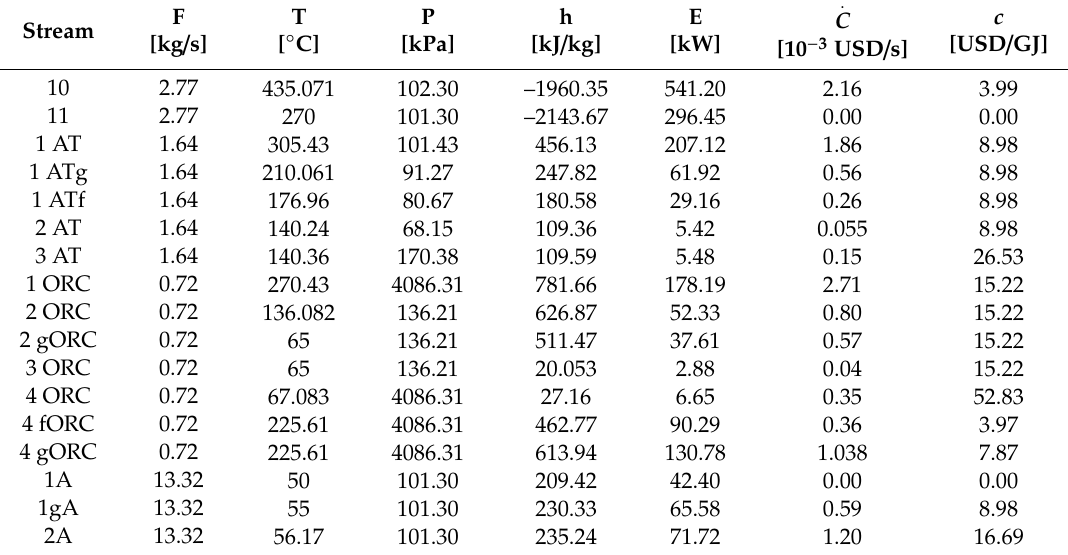
Table 6. Thermodynamic properties and cost rate for SORC with Acetone.